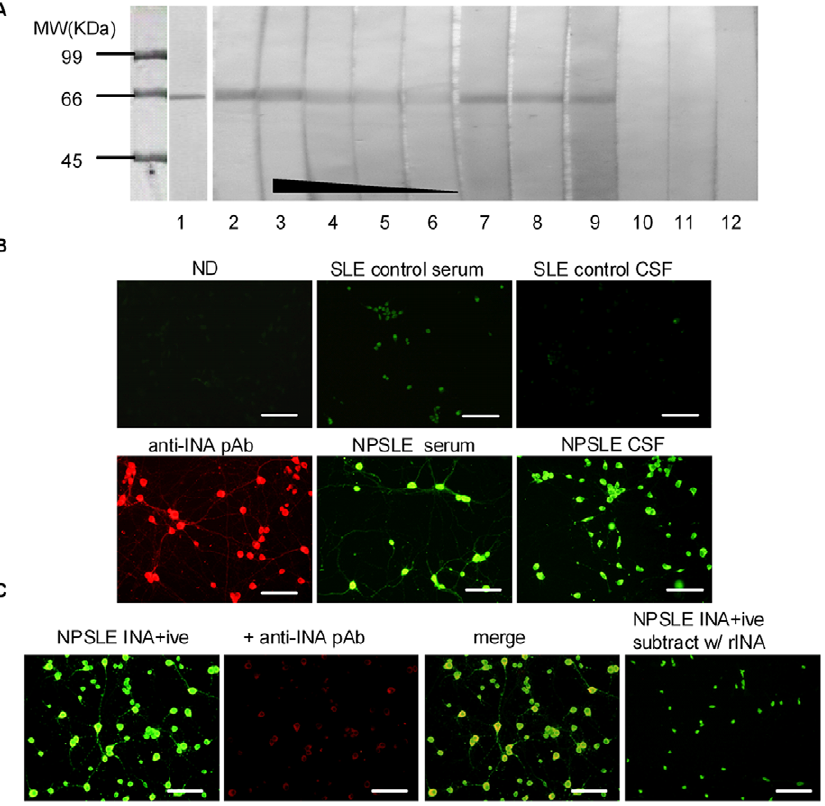
Figure 2. Anti-INA aAb in the sera and CSF of NPSLE. (A) Purified His-tagged recombinant human INA (66 kDa) was blotted with anti-His antibody (lane 1), anti-INA pAb (lane 2), NPSLE serum probe at serial dilutions of 1:200, 1:400, 1:800, 1:1000 (lane 3–6), the same patient’s CSF diluted in 1:10 and 1:20 (lane 7–8), another NPSLE serum probe and the patient’s CSF (lane 9–10), CSF from a SLE control and a neurological disease control (lane 11–12). (B) SD rat primary neuron substrate stained with serum of normal donor (ND), anti-INA pAb, serum or CSF from SLE patients as indicated. (C) NPSLE serum probe competitive inhibit anti-INA pAb staining. After pre-incubated with recombinant INA (rINA), the serum probe lost its cytoplasmic staining.